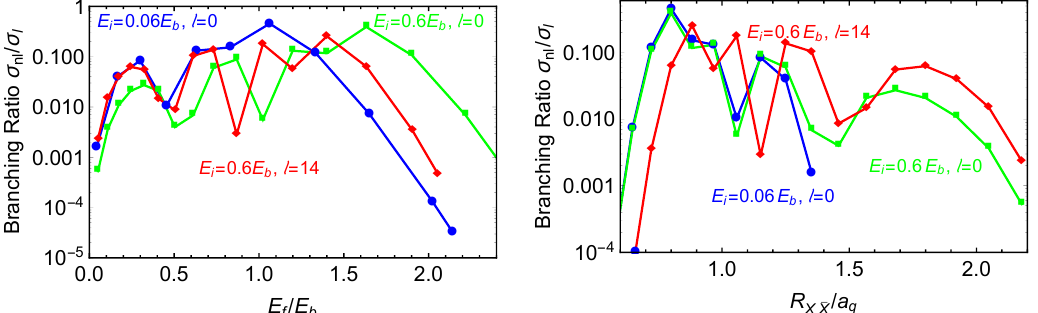
Figure 5. The branching fraction (cid:27) nl =(cid:27) l for some initial partial waves to form an ( X (cid:22) X ) quarkonium of de(cid:12)nite n; l (uniquely de(cid:12)ned by the x -axis). The results are presented for m X = 3 (cid:2) 10 4 (cid:22) (cid:11) D m q and several values of E i and l . Left panel: the branching fraction as a function of the kinetic energy in the (cid:12)nal state. Right panel: the branching fraction as a function of R the (cid:12)nal